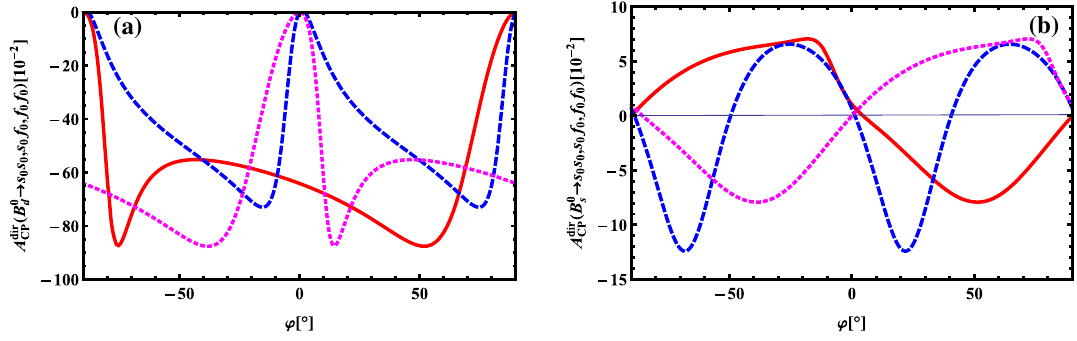
( B 0 → σσ,σ f , f ) on ϕ in the PQCD approach, in which the red-solid line, 0 0 f 0 d , s CP